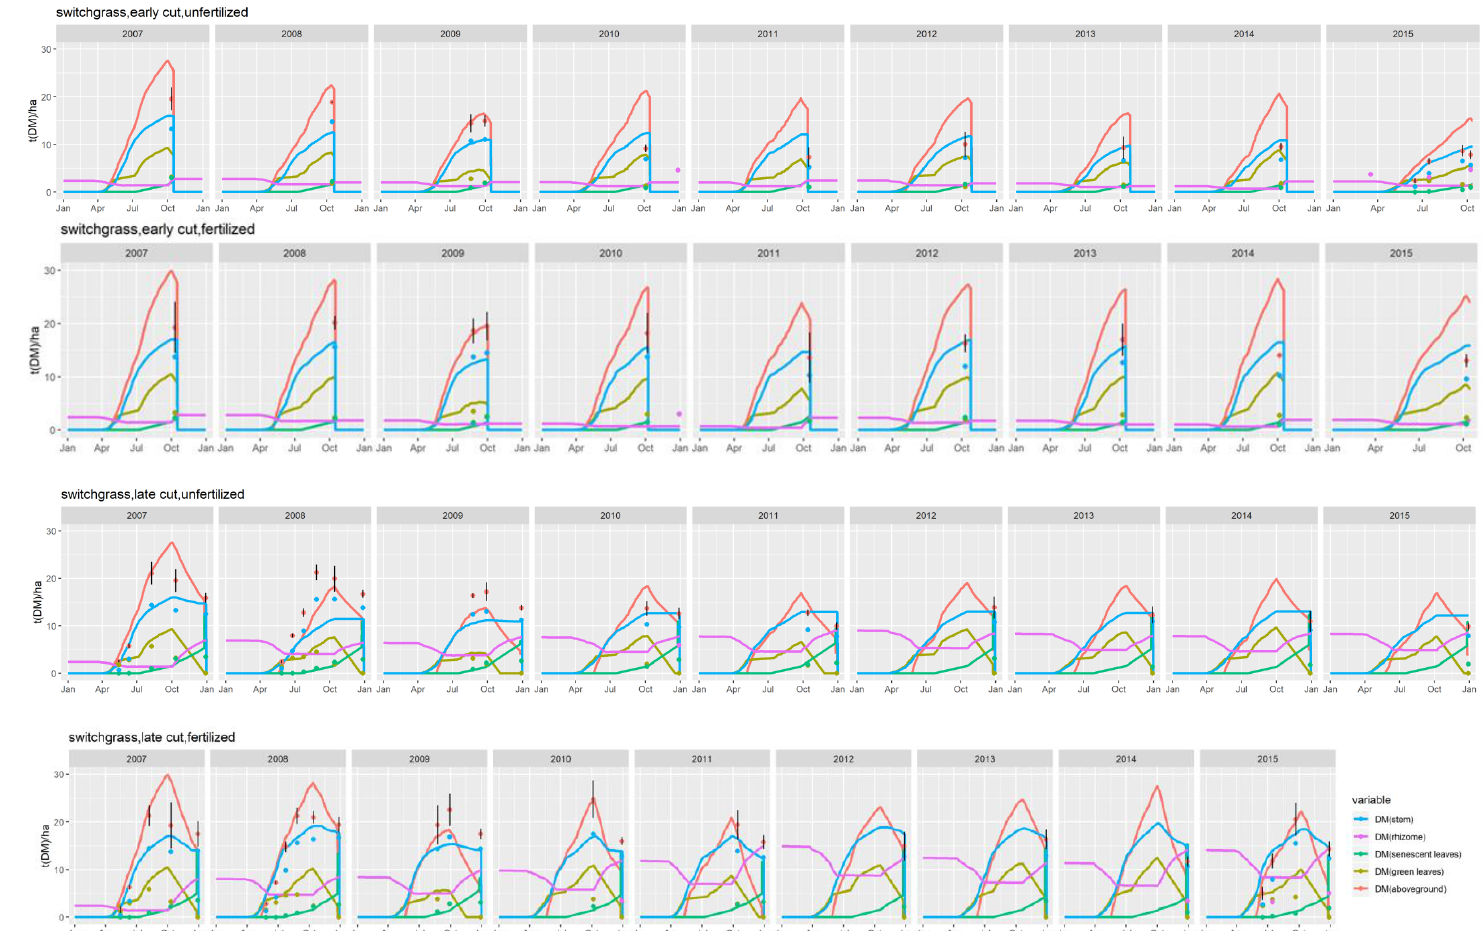
Figure 2. simulated (lines) and observed (symbols) dynamics of biomass in various plant compartments for the switchgrass trial in the Estrées-Mons calibration site, and for four treatments combining late and early harvests with two levels of N fertilizer inputs (0 and 120 kg N ha −1 ).